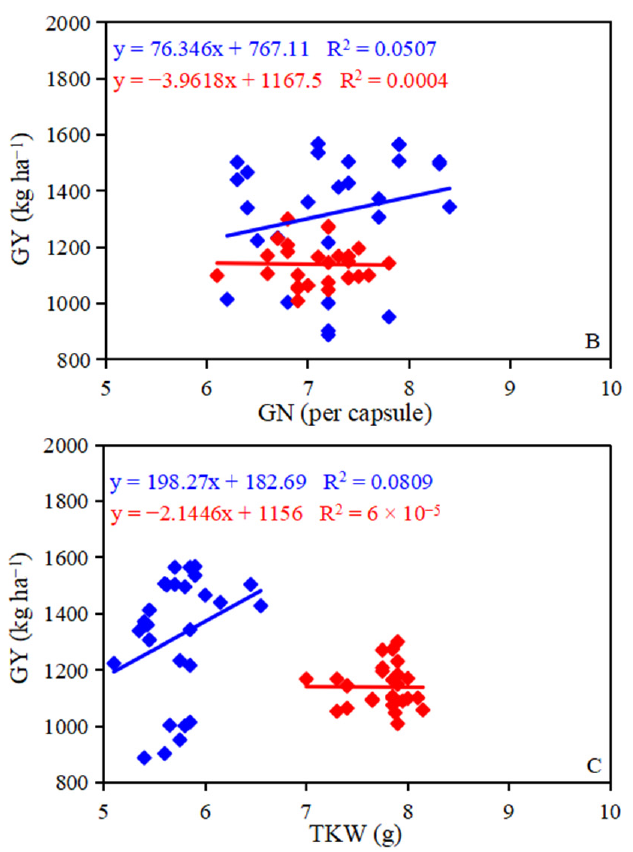
Figure 6. The relationships between GY and EC ( A ), GN ( B ), and TKW ( C ) in the 2017 and 2018. GY is grain yield, EC is effective capsule, GN is grain number, and TKW is thousand kernel weight. In two growing seasons, ET decreased with the increase in nitrogen under the same irrigation level and increased with the increase in the irrigation amount under the same nitrogen application rate (Table 4). The highest ET was observed at the I1800N0 treatment in 2017 and the I1800N120 treatment in 2018, which had significantly higher ET than other treatments. The highest WUE (3.55 kg ha − 1 mm − 1 and 2.03 kg ha − 1 mm − 1 ) of oilseed flax was observed at the I0N120 treatment in 2017 and at the I0N60 treatment in 2018. Table 4. Effects of different nitrogen and irrigation treatments on evapotranspiration, water-use efficiency, and nitrogen-use efficiency of oilseed flax in the 2017 and 2018 growing seasons.